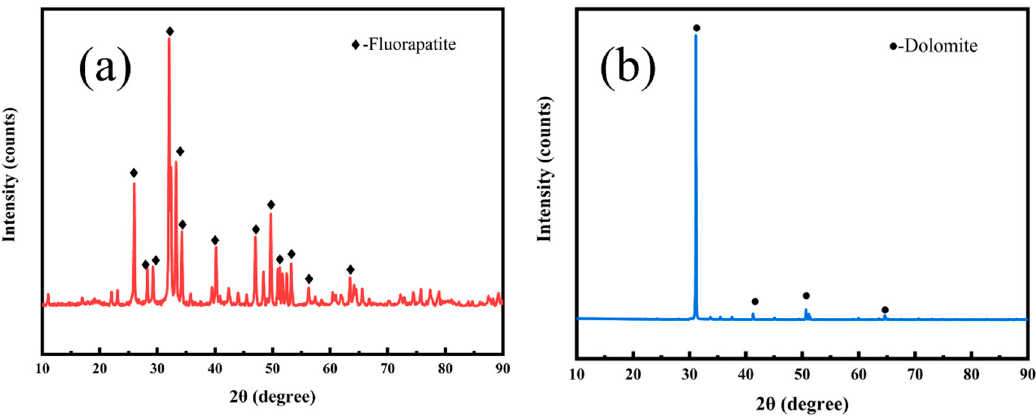
Figure 1. XRD patterns of fluorapatite ( a ) and dolomite ( b ) minerals used in the experiment.